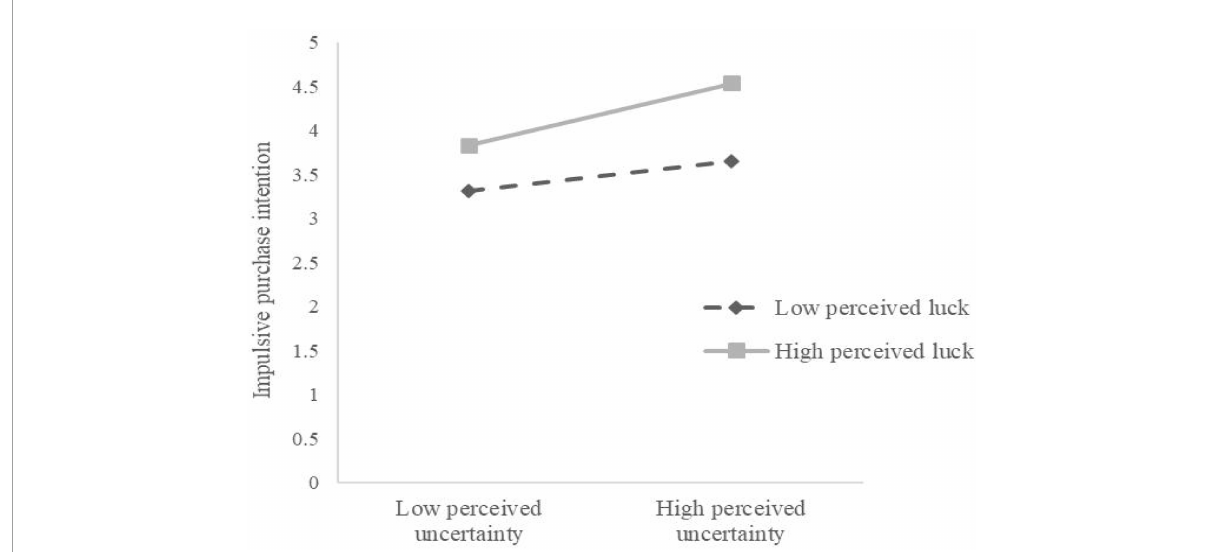
FIGURE2 Moderating effect of perceived luck on perceived uncertainty and impulsive purchase intention.